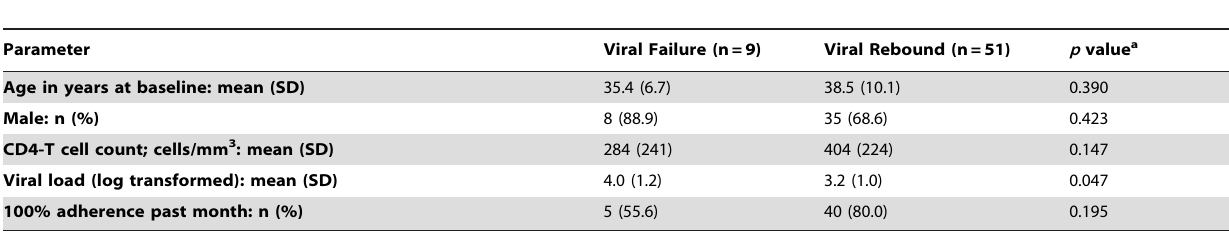
Table 2. Clinical and demographic parameters during first viral rebound for viral failure and intermittent viral rebound